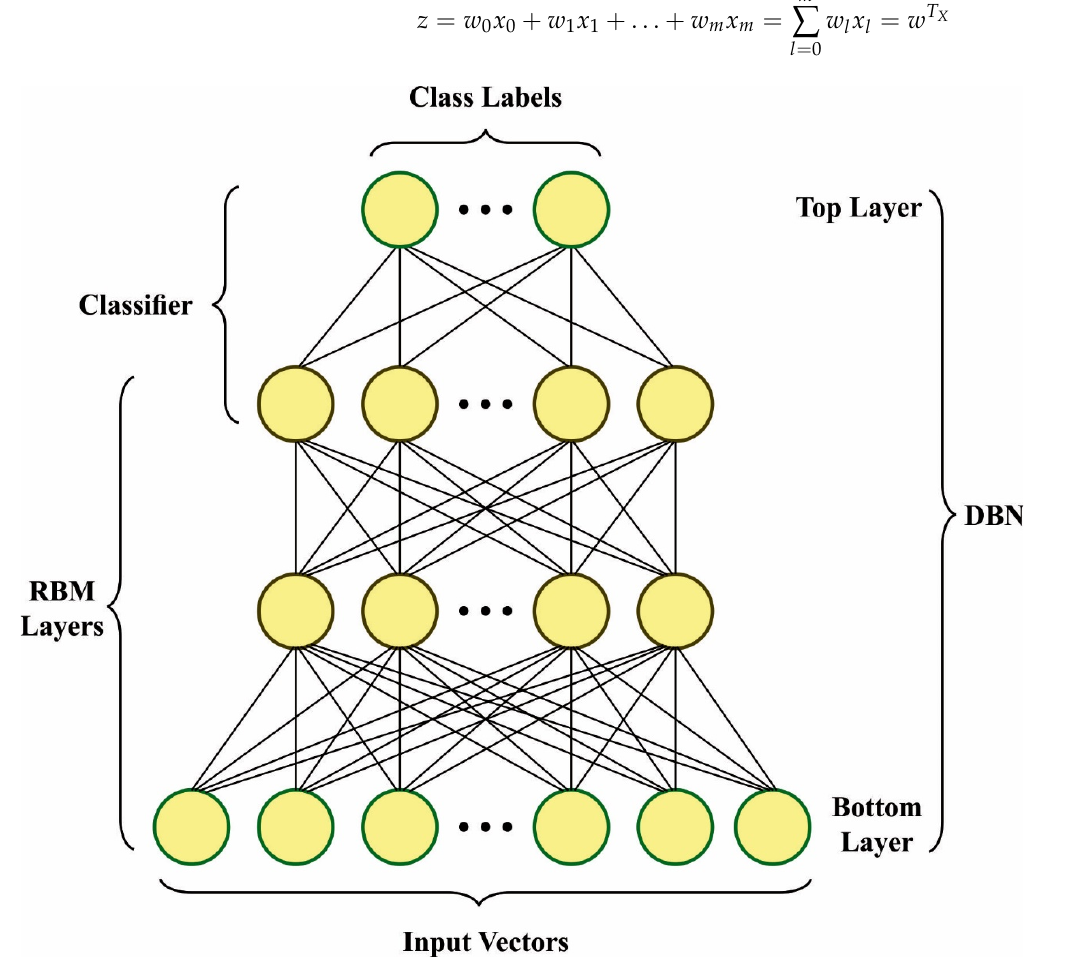
Figure 2. Architecture of DBN.